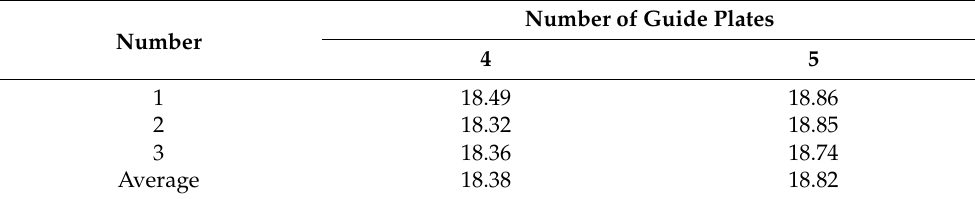
Table 7. Test verification scheme and results.